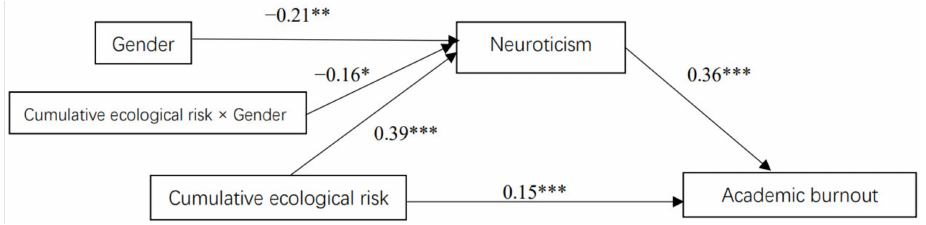
Figure 2. The moderated mediation model (male = 1, female = 0). * p < 0.05, ** p < 0.01, *** p < 0.001.